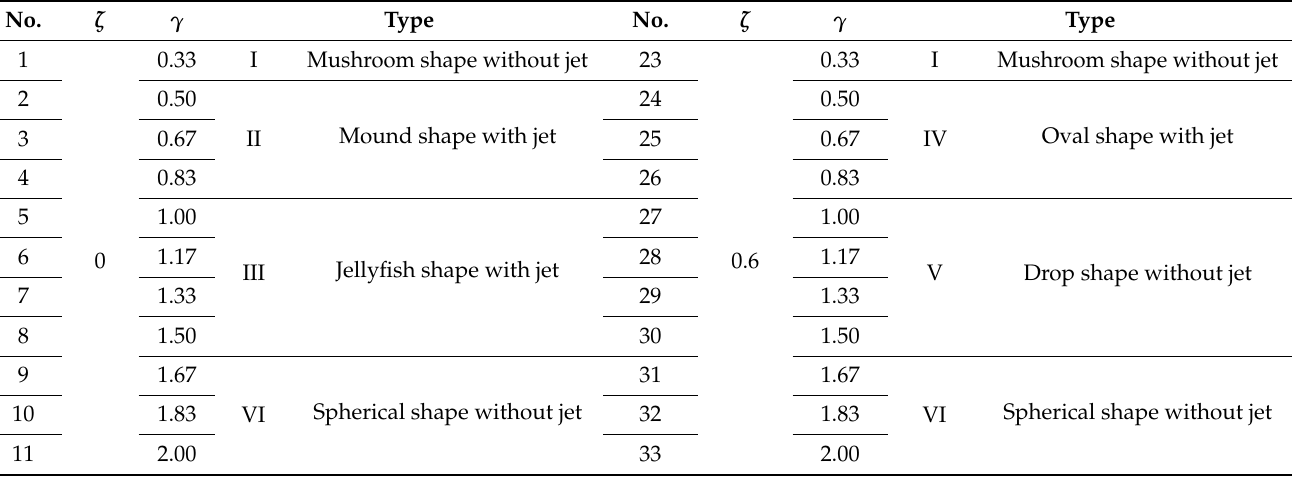
Table 3. Experimental